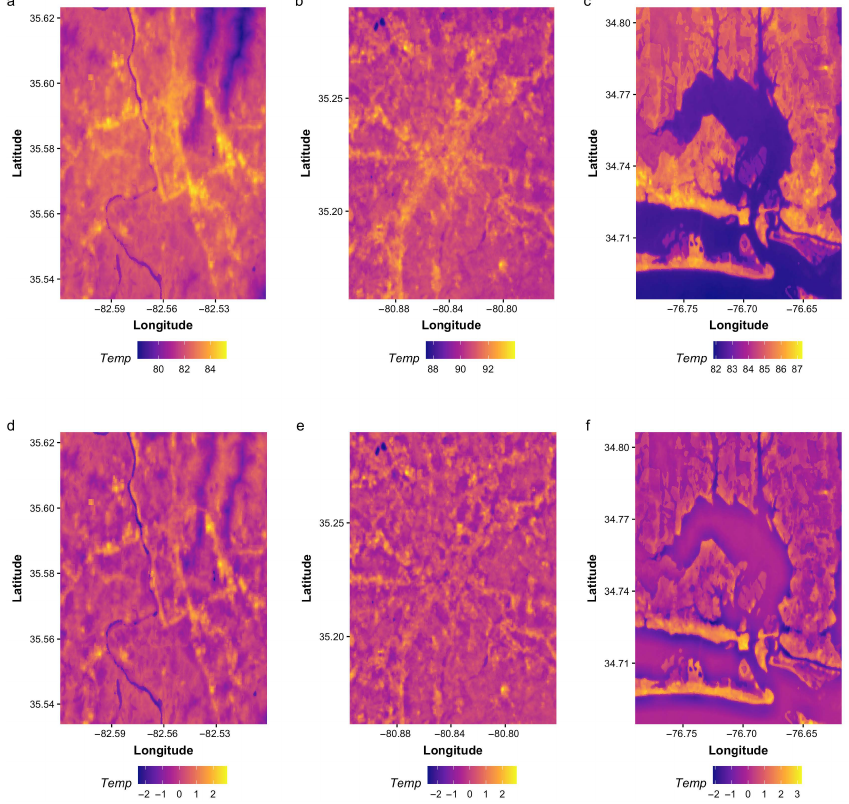
Figure 6. Estimated maximum July temperatures and thermal anomalies for Asheville ( a ), Charlotte ( b ), and Morehead City ( c ). Corresponding 1km thermal anomalies for each area shown in ( d – f ).